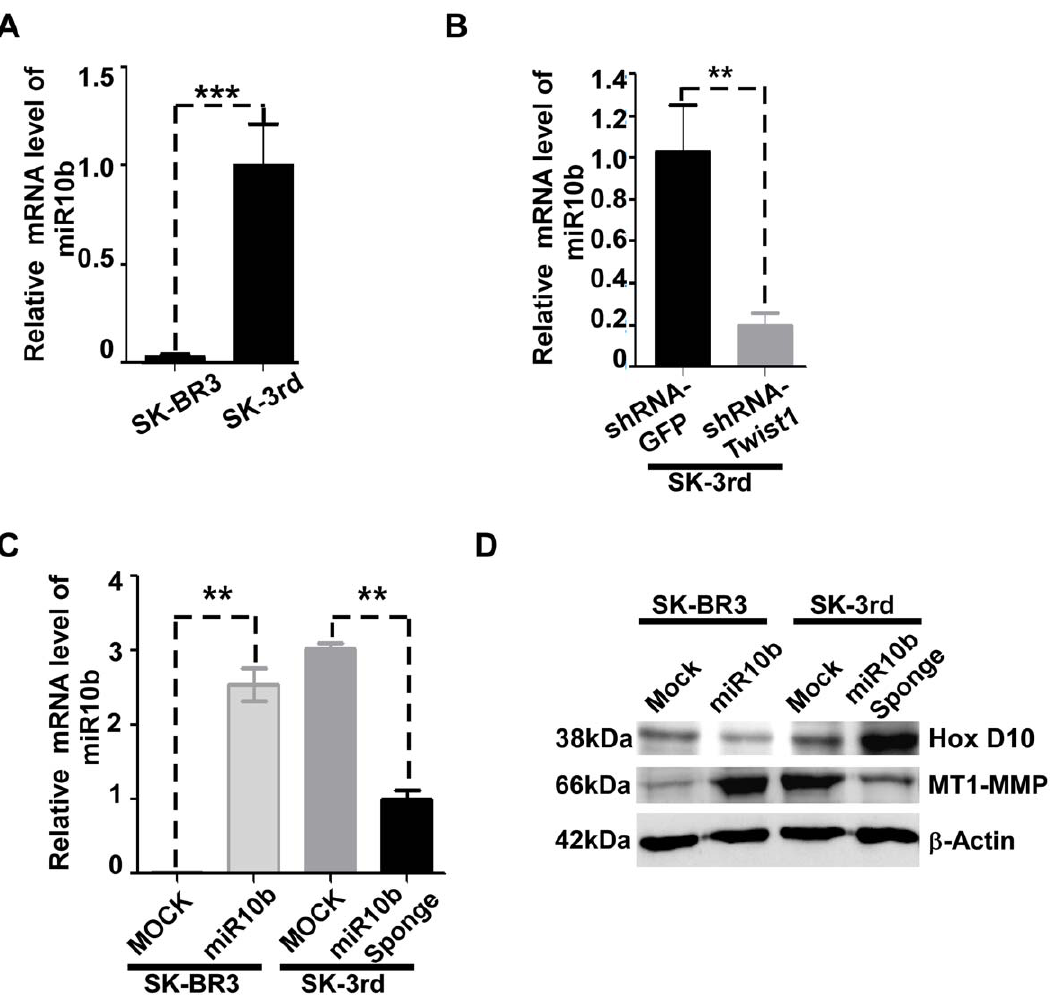
Figure 6. miR10b regulates MT1-MMP through HoxD10. A–C) Expression of miR10b in SK-3rd TICs or Twist-1 silenced-SK-3rd TICs: Total RNA was examined for expression of miR10b in cells as indicated by real time RT-PCR. Housekeeping gene (RNU6B) were used to normalize miR10b in all samples. D) Effect of miR10b on HoxD10 and MT1-MMP expression: Total cell lysates from cells as indicated were examined by Western blotting using anti-HoxD10 and MT1-MMP antibodies, respectively. b -actin was used as a loading